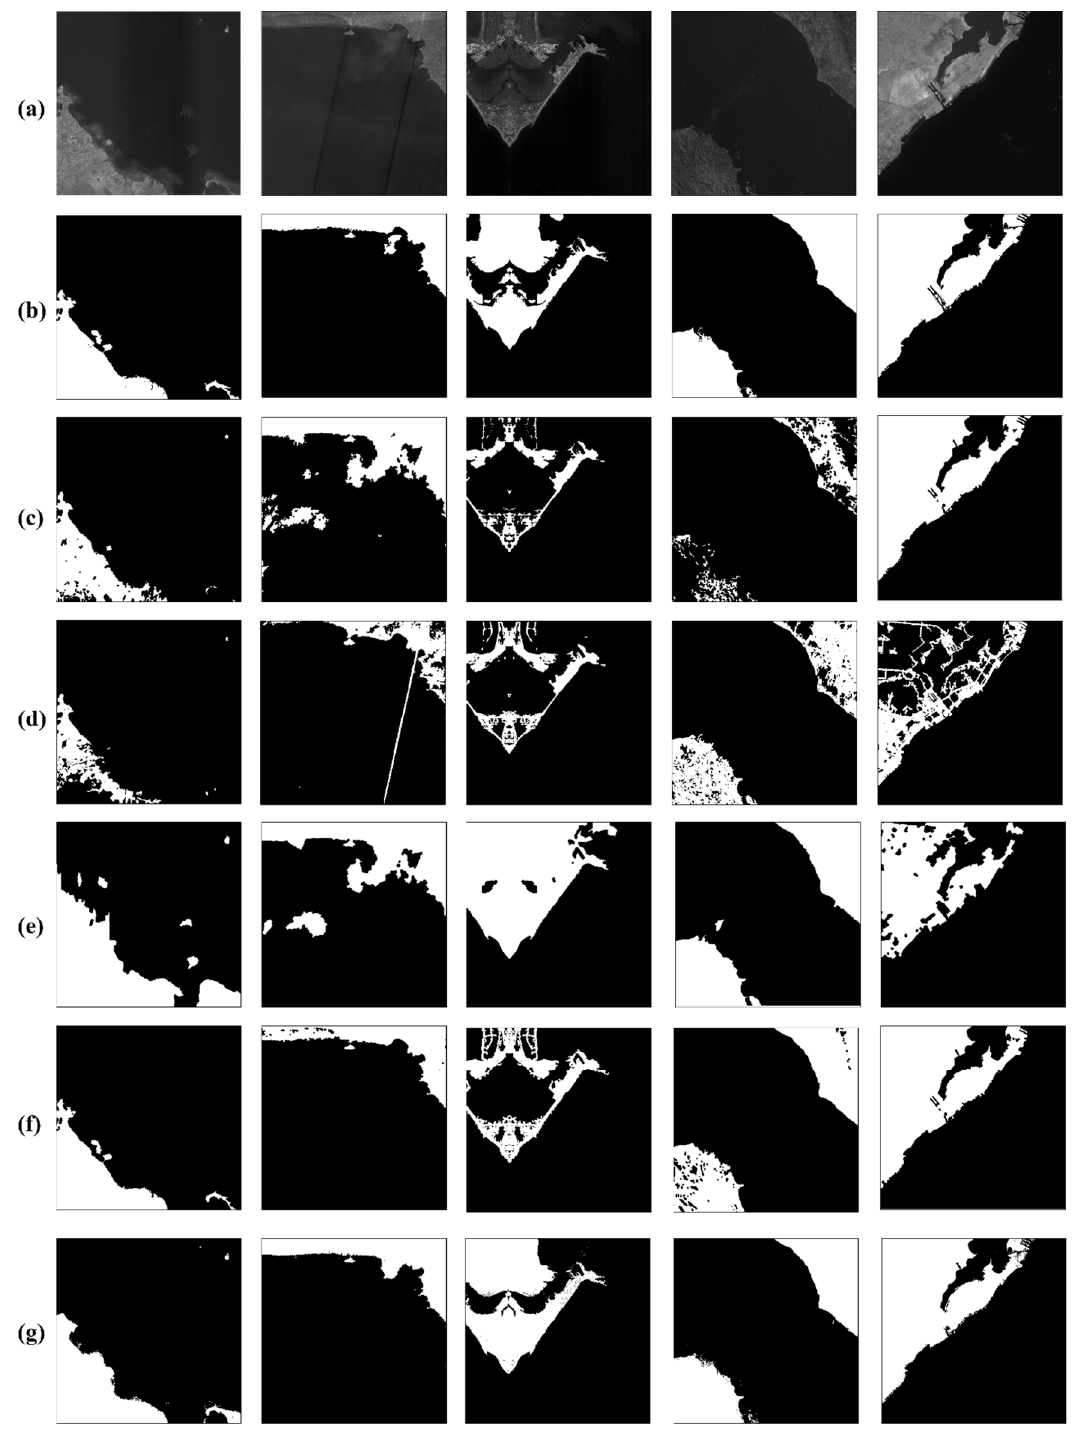
Figure 12. Results for the easy samples for testing refined water body extraction performance: ( a ) original panchromatic images, ( b ) proposed method, ( c ) GL [39], ( d ) LBP [37], ( e ) ME [30], ( f ) HSS [32], and ( g ) SeNet [23].